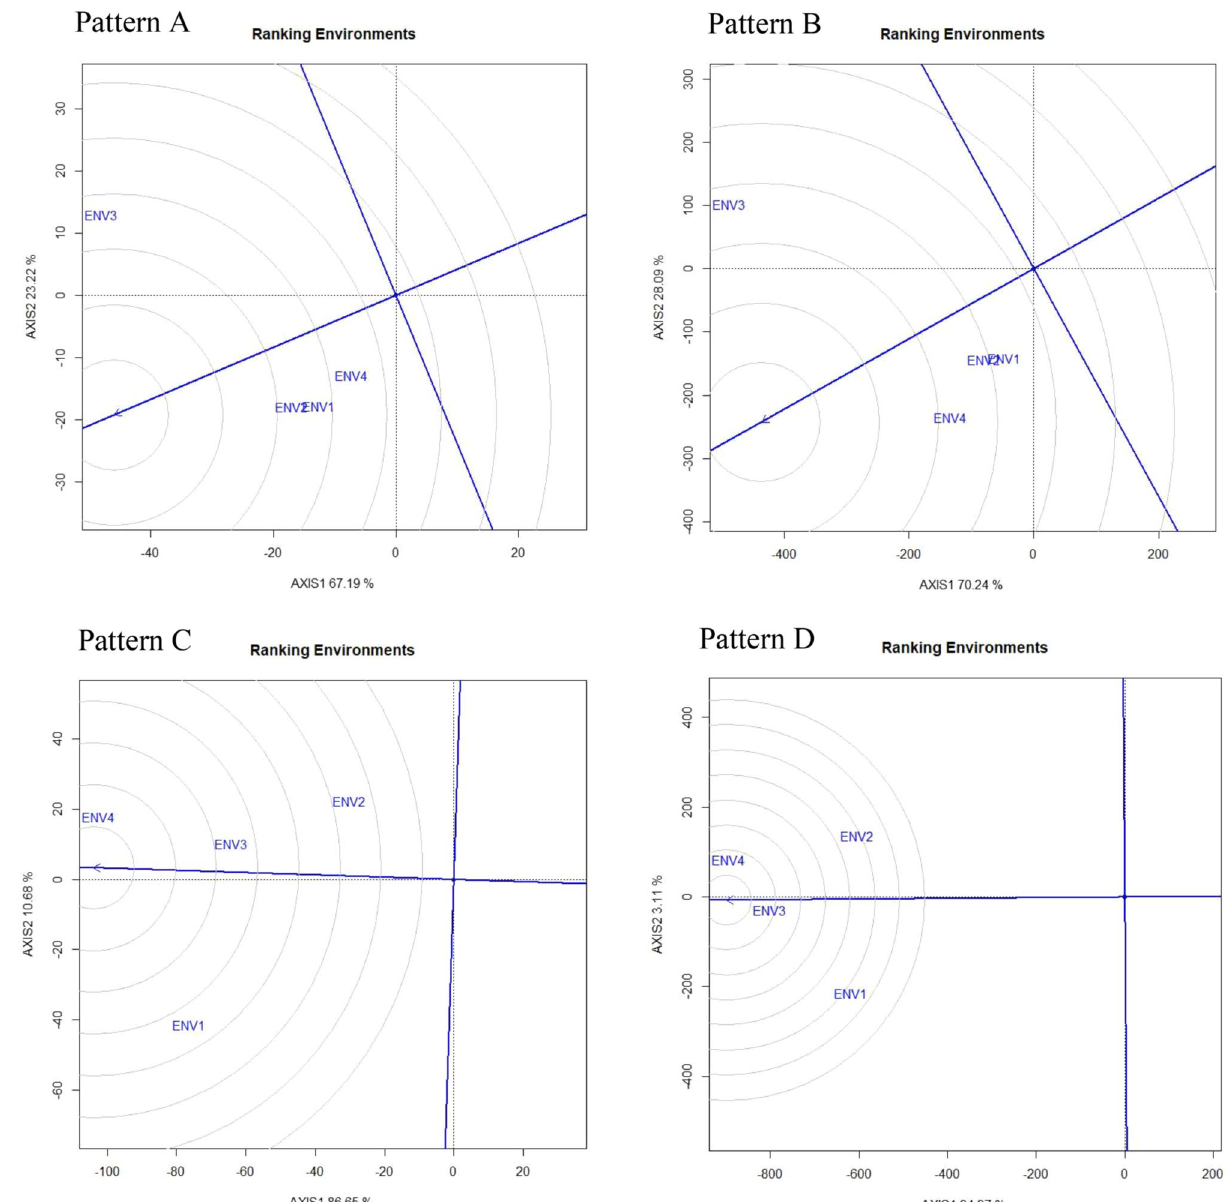
Figure 5. The GGE biplot ‘Environment ranking’ pattern for environment comparison with ideal environment showing G + G × E interaction effect of 30 V . subterranea genotypes under two season two location for total number of pods (Pattern A), fresh pod weight (Pattern B), hundred seed weight (Pattern C), yield per hectare (Pattern D). The biplots were created based on Centering = 0, SVP = 2, Scaling =